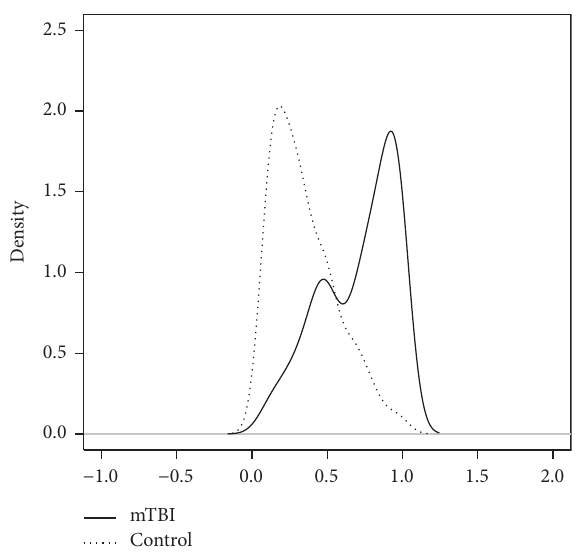
Figure 2: Propensity score density for mTBI (solid line) and control (dotted line)